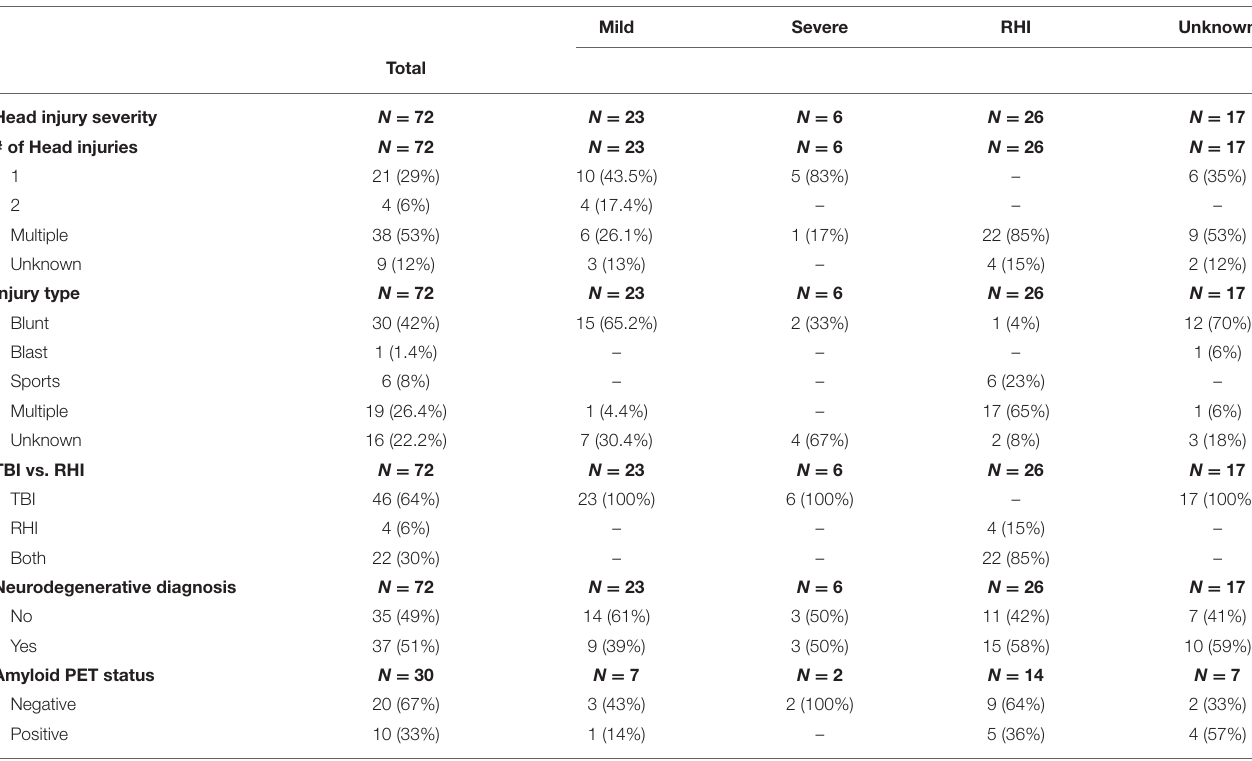
TABLE 3 | Head injury clinical characteristics subgroups.